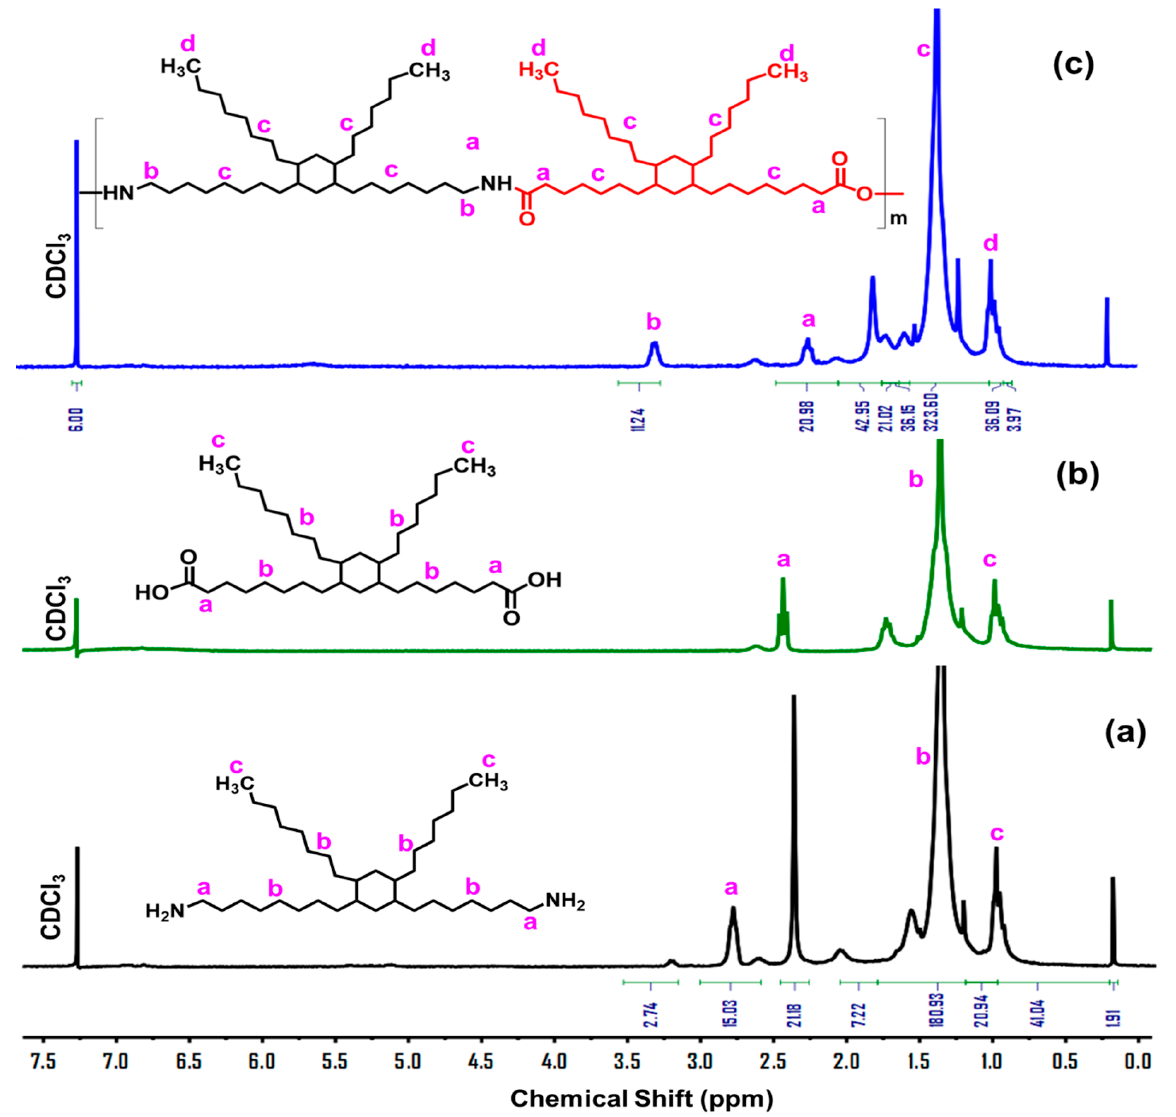
Figure 3. 1 H NMR spectra of ( a ) Priamine TM 1075, ( b ) Pripol TM 1009, and ( c ) PA36,36.